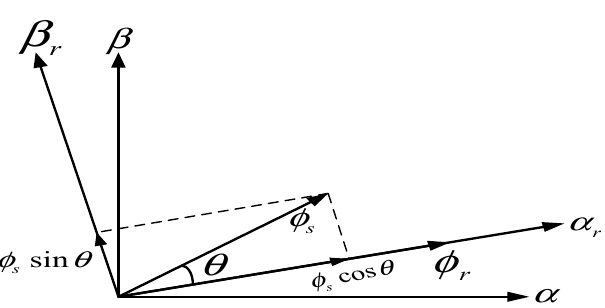
Figure 7. Flux of the rotor and stator flux vector in the rotor and stationary reference frame.